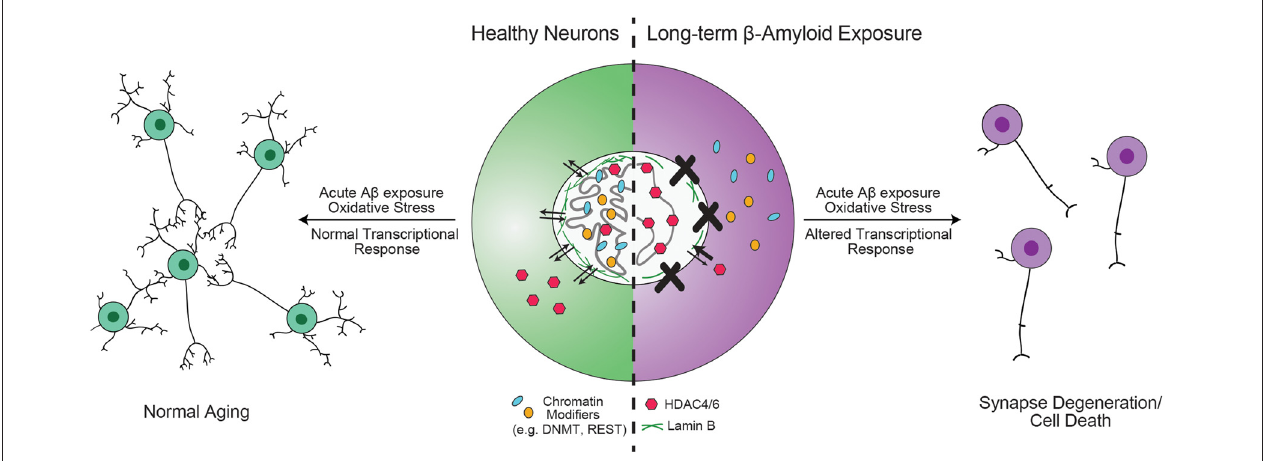
FIGURE 3 | Hypothesis for the role of chromatin organizers in the progression of Alzheimer’s disease (AD). Proteins involved in chromatin organization and topology, such as DNA methyltransferase 1 (DNMT1), repressor element 1-silencing transcription (REST) and 82-kDa choline acetyltransferase (82-kDa ChAT) are critical for the transcriptional response to acute, short-term β -amyloid peptides (A β )-exposure (Mastroeni et al., 2013; Lu et al., 2014; Winick-Ng et al., 2016). However, in mild cognitive impairment (MCI) and AD, these proteins are less localized to the nucleus (Gill et al., 2007; Mastroeni et al., 2013; Lu et al., 2014). Other epigenetic modifiers, such as HDAC4 and HDAC6 have increased localization in the nucleus (Sen et al., 2015). In addition, mutant tau expression leads to reduction in lamin B and loss of heterochromatin (Frost et al., 2016). The redistribution of DNMT1 may be due to long-term A β -exposure (Mastroeni et al., 2013), but is unknown for other proteins. As a result of mislocalization of REST, neurons are unable to respond appropriately to oxidative or A β stress, leading to aberrant transcription that results in synapse degeneration and cell death (Lu et al., 2014).